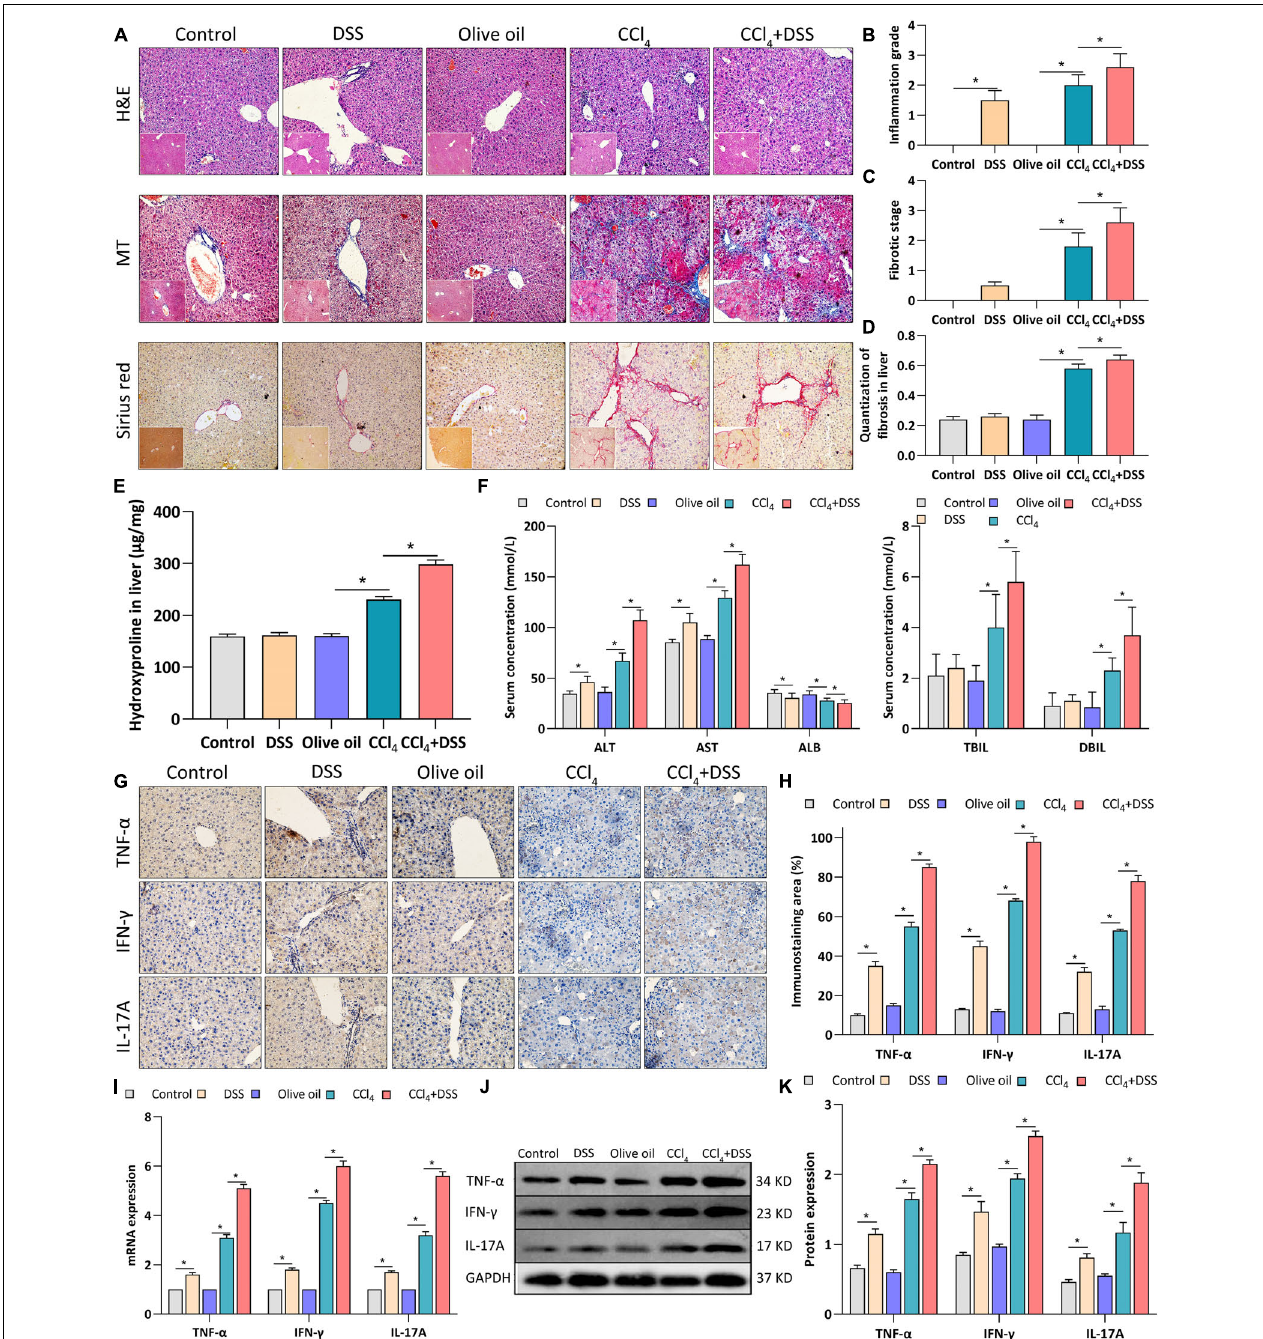
FIGURE 2 | DSS-induced colitis aggravated liver damage, fibrosis and inflammation in CCl4-induced liver fibrosis mice. (A) Representative images of H&E staining, Masson’s trichrome (MT) or Sirius red liver sections (magnifications × 200); (B) Inflammation grade; (C) fibrotic stage and (D) quantitative analysis of fibrous tissue were shown; (E) The content of hydroxyproline in liver tissue; (F) Serum levels of liver function indexes; (G) Representative images of IHC staining liver sections (magnifications × 400) and (H) staining intensity of pro-inflammatory cytokines were shown. (I–K) Expression levels of pro-inflammatory cytokines in liver were measured by qRT-PCR (I) and western blot (J,K) . Data were expressed as mean ± SD. *, p < 0.05.